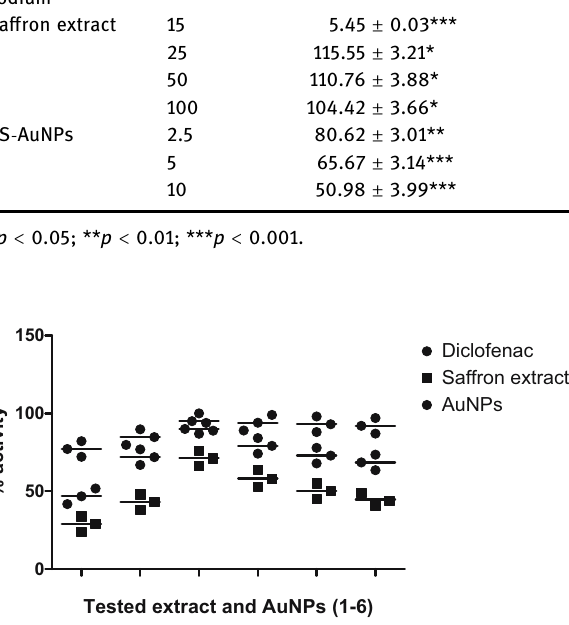
Figure 19: Antiin fl ammatory activity of extract and AuNPs of Crocus sativus ( extract 100mg/kg; AuNPs 10mg/kg ) on carrageenan paw edema on mice. All values were represented as ± SEM for groups of six animals. The data were analyzed by ANOVA followed by Dunnett ’ s